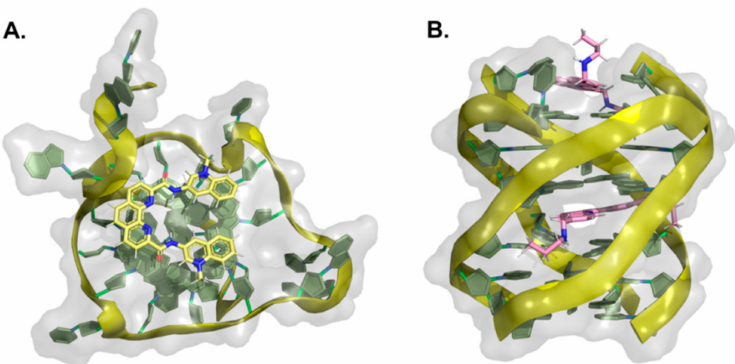
Figure 10. Representation of ( A ) a phenanthroline derivative in complex with G4 derived from the c-MYC promoter (2MGN) and ( B ) a quinacridine derivative in complex with a tetramolecular G4